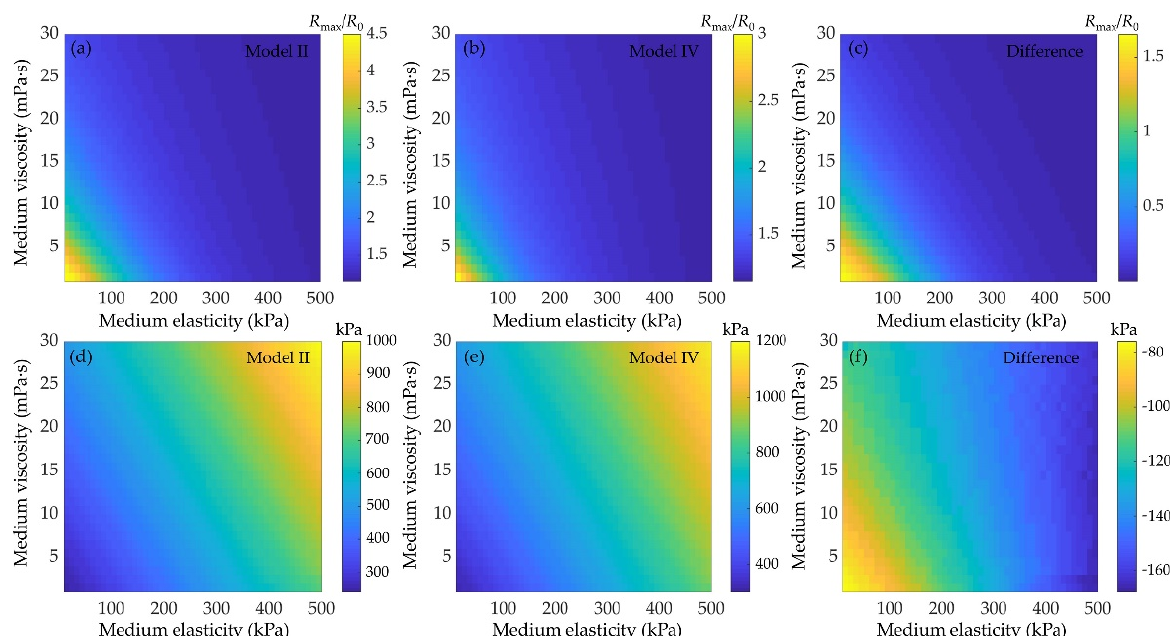
Figure 9. Effects of medium viscoelasticity on the bubble dynamics and inertial cavitation threshold. Maximum expansion ratio of a 1 µ m lipid-coated microbubble at different elasticities and viscosities of the surrounding medium ( a ) without (model II) and ( b ) with (model IV) considering bubble − bubble interactions ( p A = 400 kPa, R 10 = 1 µ m, R 20 = 5 µ m and d i,j = 20 µ m), and ( c ) represents the difference between them. ( d – f ) represent the corresponding results of inertial cavitation threshold.